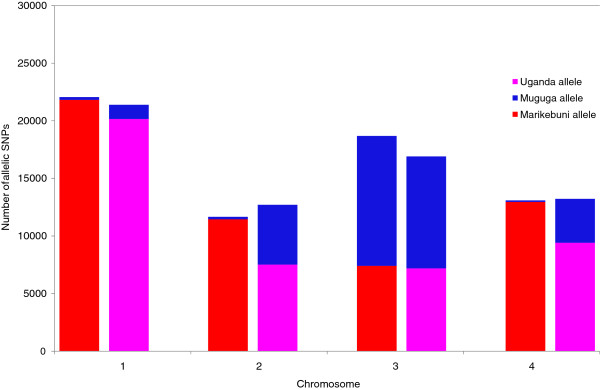
Allelic SNP distribution in progeny strains MugugaMarikebuni and MugugaUganda. In both progeny strains, all chromosomes except chromosome 3 had predominantly non-Muguga alleles. MugugaMarikebuni is depicted in the left and MugugaUganda in the right bars for each individual chromosome.